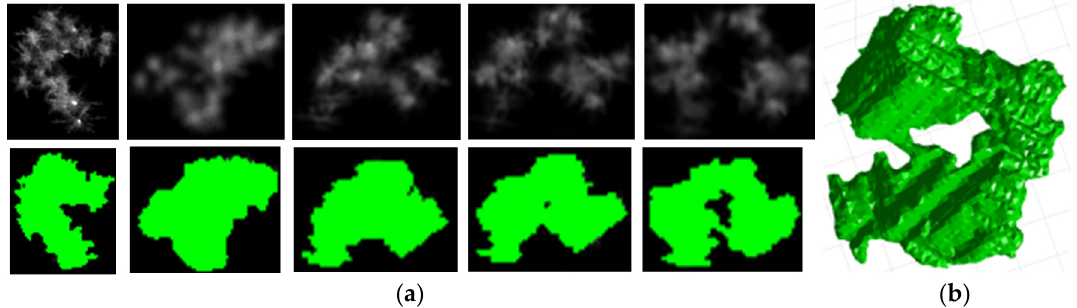
Figure 5. An example of snowflake reconstruction by the visual hull method based on five photographs of a snowflake collected by the new 5-camera CSU MASC system in Figure 1e: ( a ) MASC images and corresponding projections of the visual hull generated 3D mesh to camera image planes and ( b ) the resulting triangular 3D mesh of the snowflake.